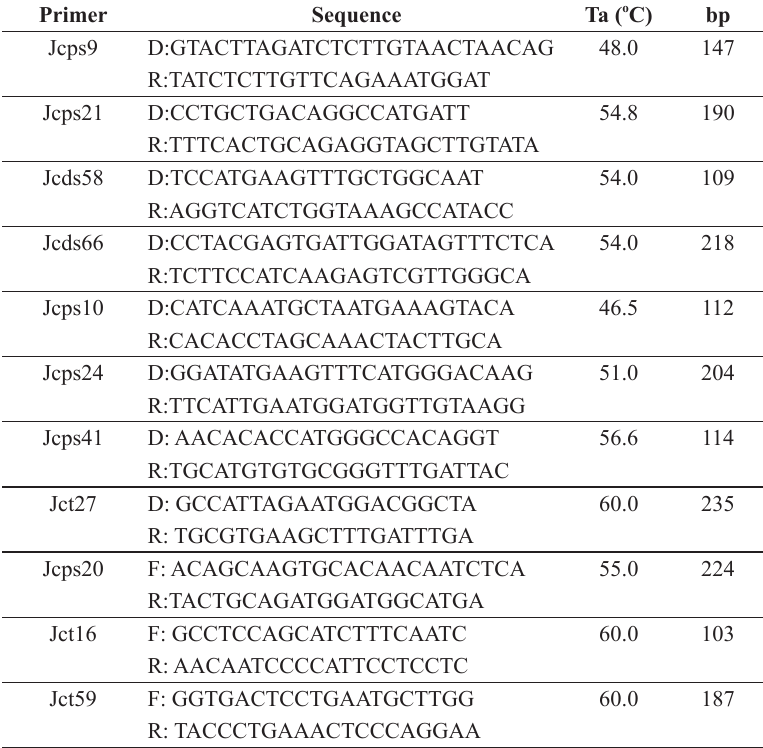
ssr jatropha primers used to evaluate 48 jatropha accessions, with respectively sequences, annealing temperatures (Ta) and allele sizes